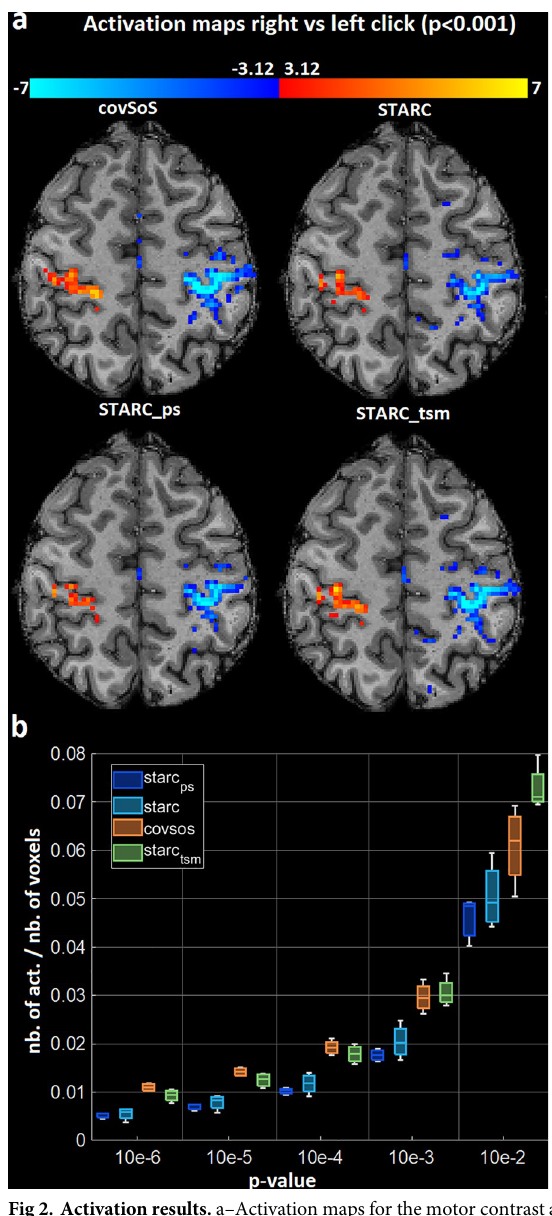
Fig 2. Activation results. a–Activation maps for the motor contrast at p < 0.001 (no correction) for covSoS, STARC, STARC ps and STARC tsm . No double-dipping correction was applied to STARC tsm . The shown maps are from the same volunteer as in Fig 1. b–Total number of activated voxels relative to the total number of voxels at different p-values and for different coil combinations, pooled over the volunteers. STARC ps and STARC have the poorest performance in terms of BOLD detection. CovSoS has the highest number of activations for the lowest p-values but STARC tsm (without double-dipping correction) reports more activations for the highest